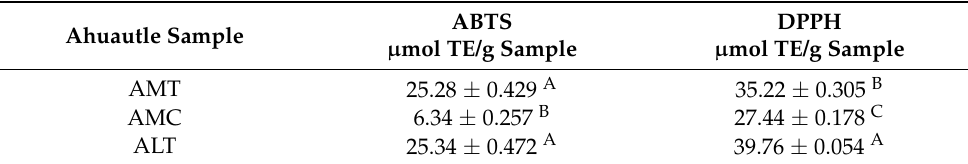
Table 4. Antioxidant activity of Corixidae eggs determined by ABTS and DPPH measured as µ mol TE (Trolox Equivalent/g sample).